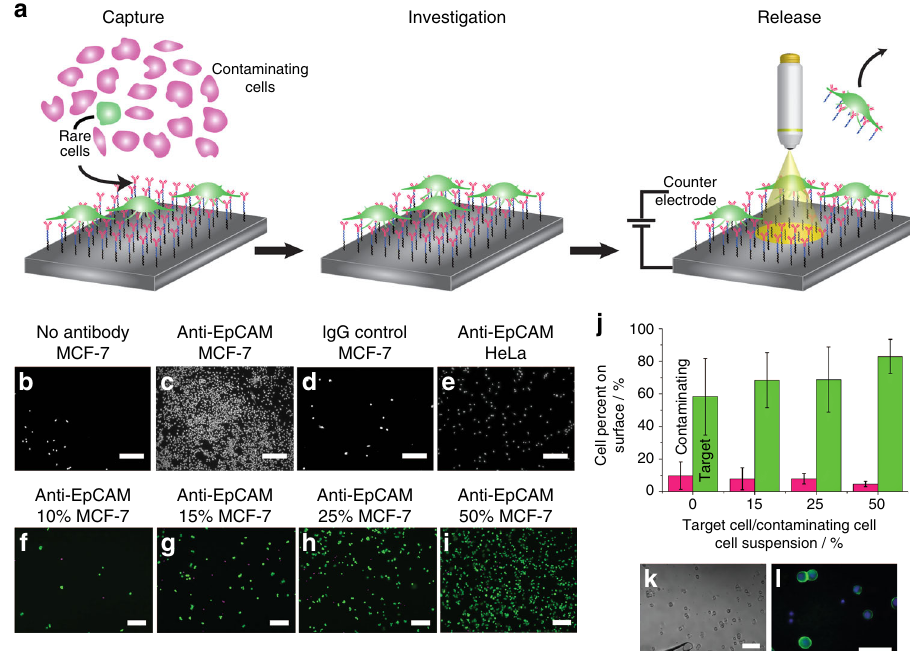
Fig. 1 Capture performance of the antibody-modi fi ed silicon surface. a The capture and release device. Rare cells (green) are pre-concentrated on an electrochemically cleavable antibody-modi fi ed poorly doped p-type silicon surface from a mixture of cells (left). The pre-concentrated cells can be simultaneously analysed, for example with fl uorescence microscopy (middle) before a unique single cell is selected and electrochemically released from the surface (right). b – e Fluorescence micrographs of live MCF-7 cells plated on an oligo(ethylene oxide)-terminated surface ( b ), an anti-EpCAM-modi fi ed surface ( c ), on a surface with non-speci fi c donkey anti-mouse IgG antibody ( d ) and HeLa cells on an anti-EpCAM-modi fi ed surface ( e ). Cells were stained with the nuclear dye Hoechst 33342. Scale bar = 200 μ m. f – i Fluorescence microscopy images of MCF-7 cells spiked into HeLa cells at 10% ( f ), 15% ( g ), 25% ( h ) and 50% ( i ) MCF-7 cells of total cells. MCF-7 cells were stained with calcein (green) while HeLa cells were stained with a Hoechst 33342 nuclear stain (magenta). Scale bar = 100 μ m. j Quantitation of MCF-7 and HeLa cell densities on the silicon surfaces as a function of their composition in suspension. Error bars represent the margin of error at 95% con fi dence, n = 6. k – l MCF-7 cells were spiked (1% of total cells) into whole human blood before being captured on an anti-EpCAM-modi fi ed electrochemically cleavable silicon surfaces. All mononuclear cells were stained with the Hoechst 33342 nuclear dye (blue) whilst EpCAM-positive MCF-7 cells were also stained with FITC-conjugated anti-EpCAM antibodies (green). Scale bar in k = 100 µ m; scale bar in l = 50 µ